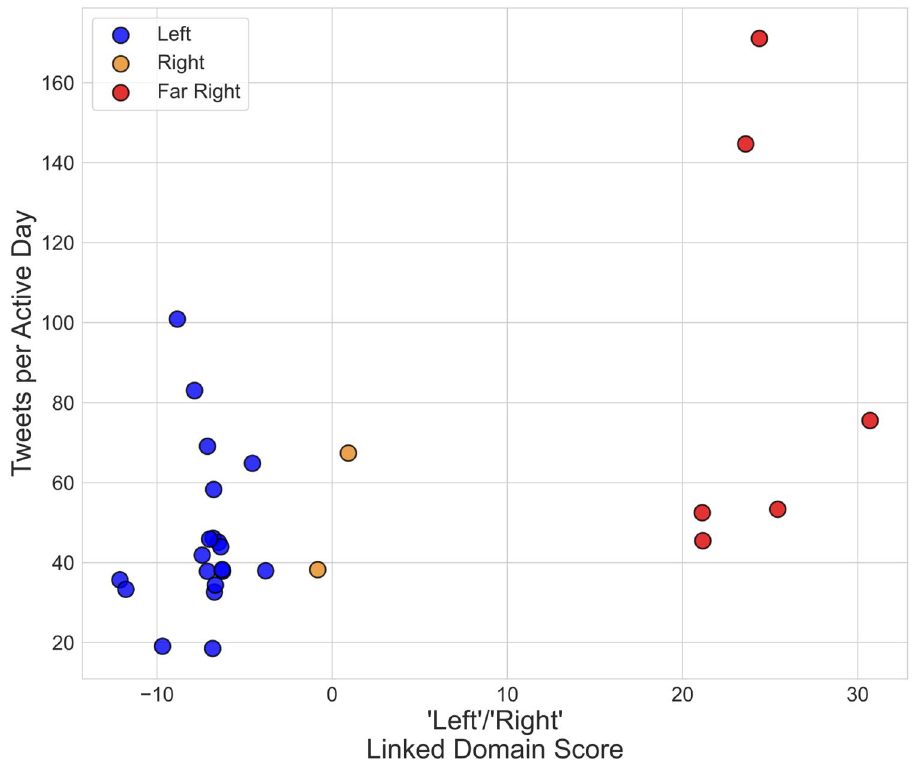
Figure 2. Sentinel communities projected onto the first component of the linked domain PCA space. Colors correspond to clusters resulting from mean linkage clustering on the first principal component score. The vertical axis corresponds to the total tweets posted by the community over the observation period, normalized by the number of active days for the community’s sentinel nodes (Methods, Section "Sentinel recruitment and data